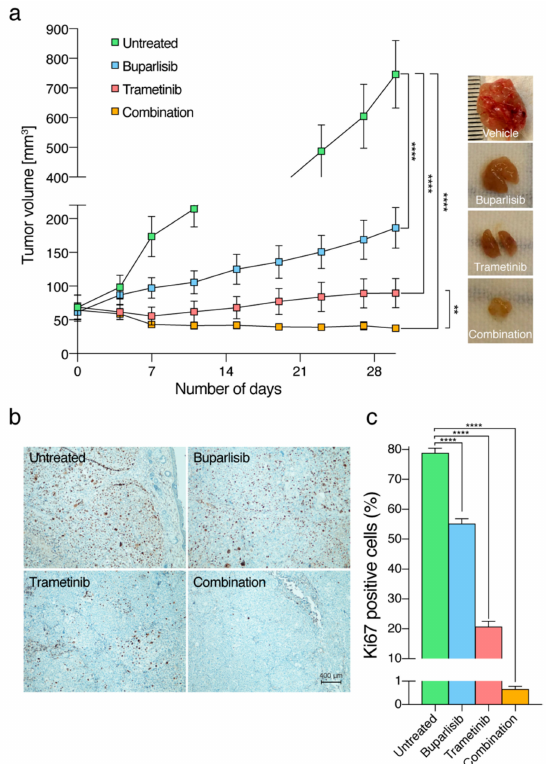
Figure 7. Inhibition of in vivo tumor growth after treatment with 50 mg / kg buparlisib and 1 mg / kg trametinib. ( a ) tumor volumes plotted as a function of time to assess tumor growth in response to therapy. The tumors were measured once a week and at the end-point of the experiment (30 days). Representative images of subcutaneous tumors after termination of the experiment can be seen on the right ( n = 8 mice in each treatment group); ( b ) immunohistochemistry sections from representative mice from each treatment group stained with antibodies against Ki67 (imaged with a 10 × objective); ( c ) quantification of the number of Ki67 positive cells in each treatment group. Abbreviations: **: p < 0.01 and ****: p <